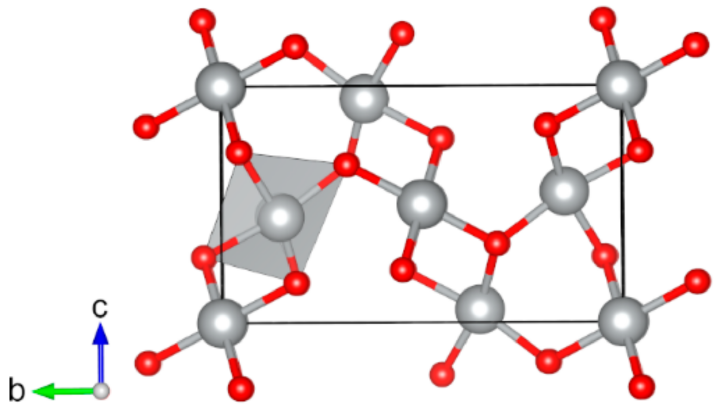
Figure 9. Optimized structure of Ag 3 O 4 ( mP 14) (red: O, light grey: Ag). Spins are aligned up along c axis and not visualized. Square planar coordination of Ag atoms is shown in a light-grey